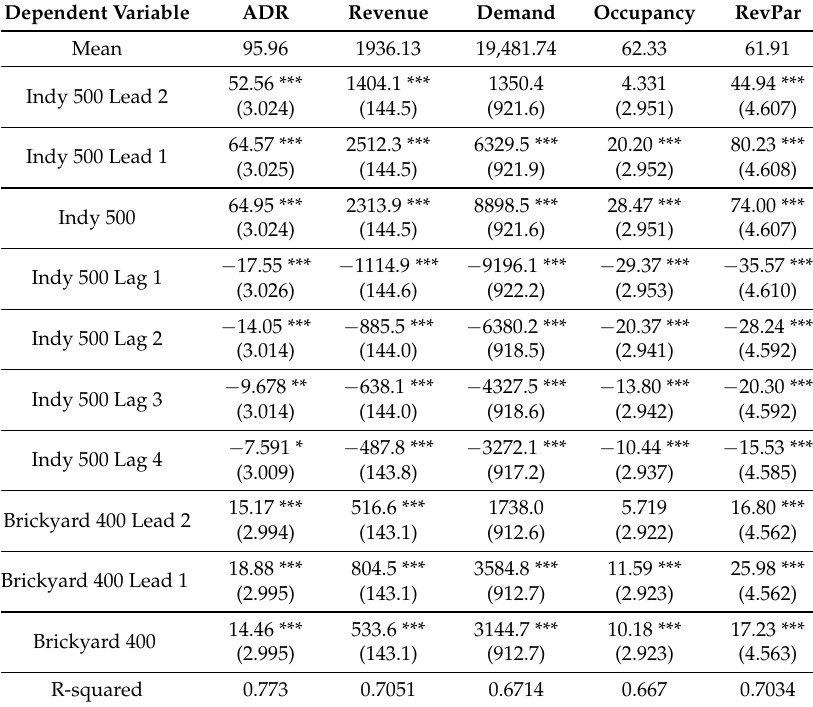
Table 9. The impact of the Indy 500 and the Brickyard 400 on the hotel